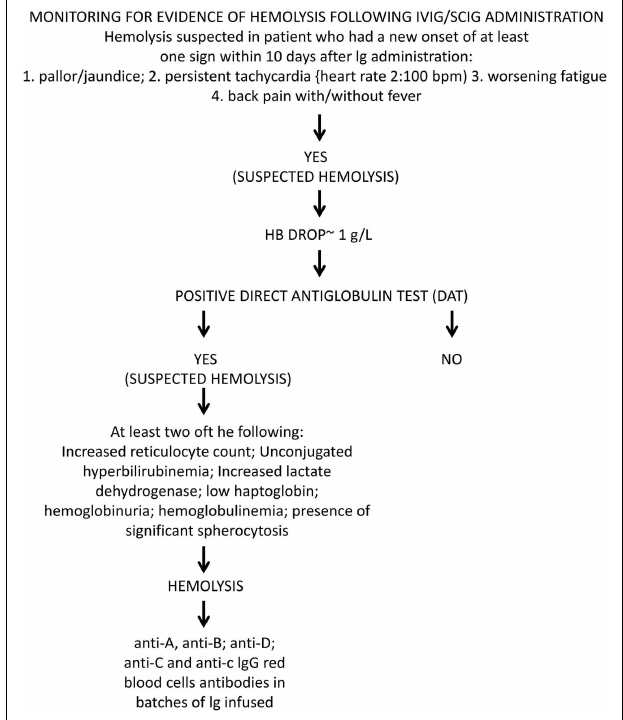
FIGURE 7 | Monitoring for evidence of oxygen missing at the dark side . Diagnostic algorithm for Ig-induced hemolysis according to criteria elaborated by the Canadian Group